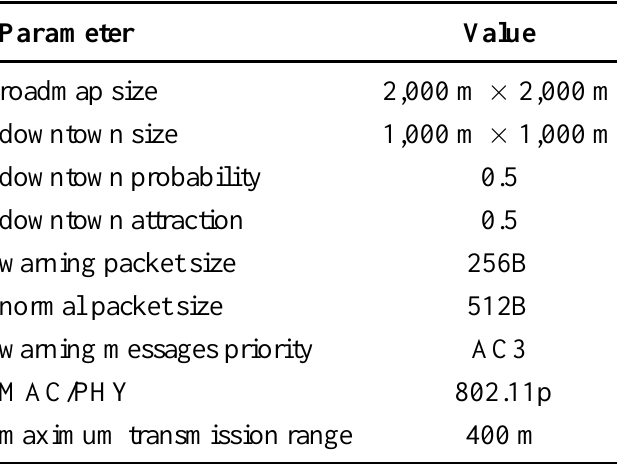
Table 4. Parameters used for the